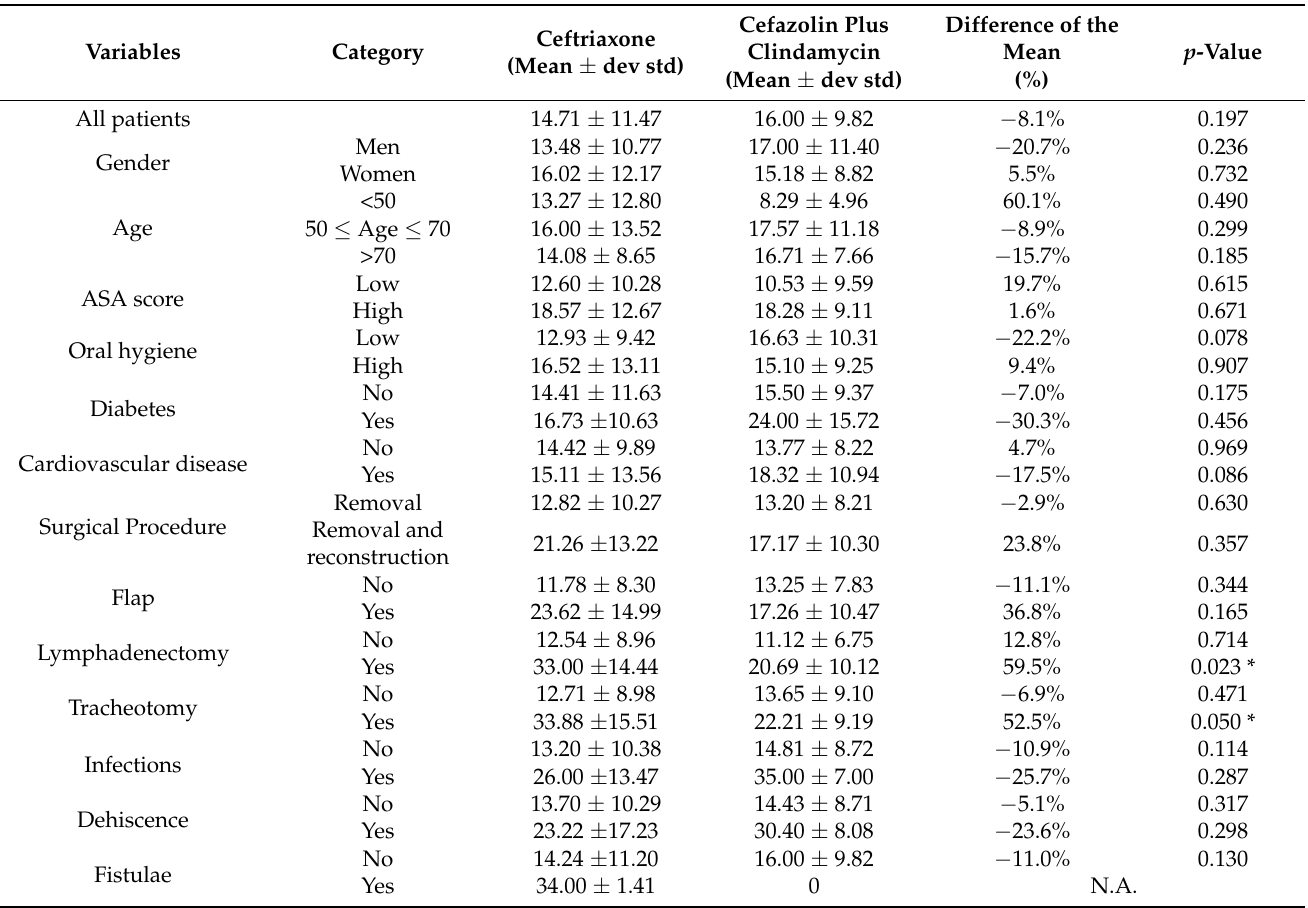
Figure 5. As per Six Sigma methodology, visual management (Box plot) is employed to provide readers with a graphical representation of LOS for both groups. The numbers over the boxes can be considered outliers. Table 4. Statistical analysis of LOS: a comparison between Ceftriaxone and Cefazolin plus Clindamycin is performed for the categories of each variable. * Significance at 0.05; ** significance at 0.01; *** significance at